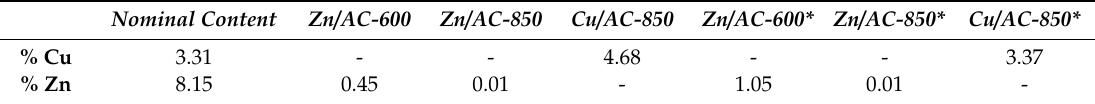
Figure 4. SEM images of Zn / AC-600 ( a ) and Cu / AC-600 ( b ). Table 2. Copper and zinc content in AC samples determined by ICP-MS analysis and nominal content of metals evaluated on the basis of metal chlorides introduced in FA for